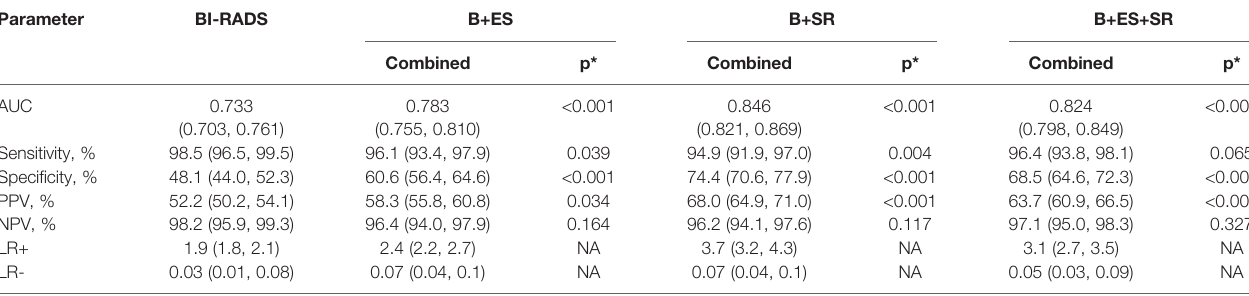
TABLE 5 | Diagnostic value of BI-RADS and combined tests with strain ratio and/or elasticity score. Parameter